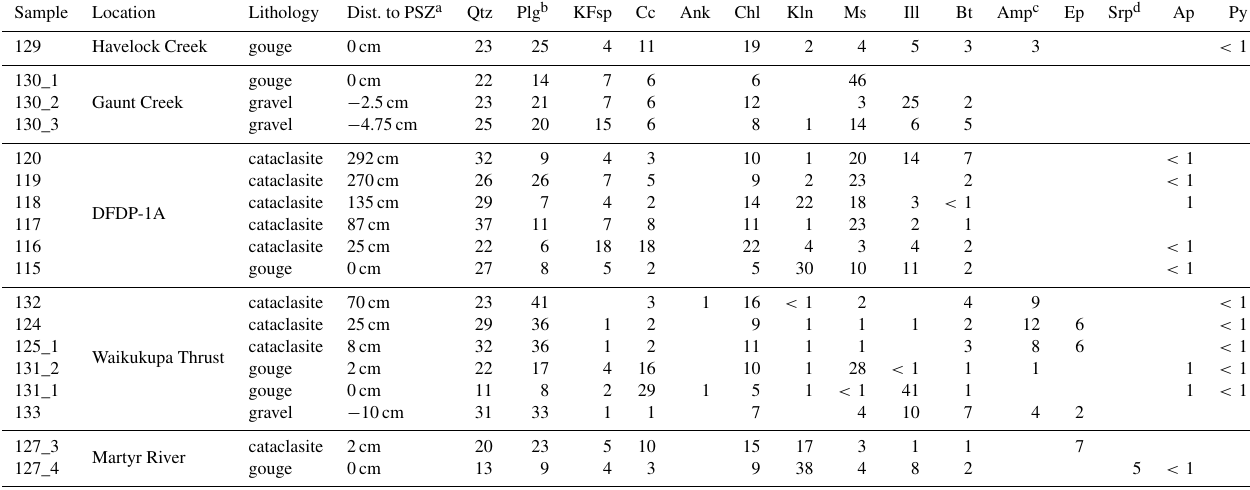
Table 4. Mineralogical composition [wt%] of investigated samples as determined by XRD analysis and subsequent Rietveld refinement. Mineral abbreviations are: Qtz: quartz; Plg: plagioclase; KFsp: potassium feldspar; Cc: calcite; Ank: ankerite; Chl: chlorite; Kln: kaolinite; Ms: muscovite; Ill: illite; Bt: biotite; Amp: amphibole; Ep: epidote; Srp: serpentine group minerals; Ap: apatite; Py: pyrite.